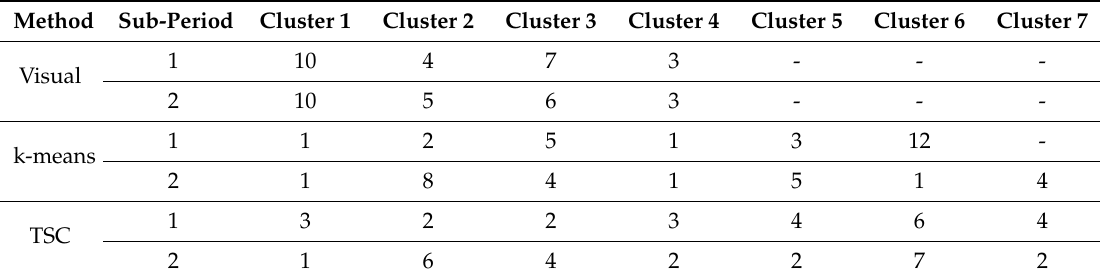
Table 1. Number of piezometers in each obtained cluster. Sub-period 1: from October 1975 to September 1995. Sub-period 2: from October 1995 to September